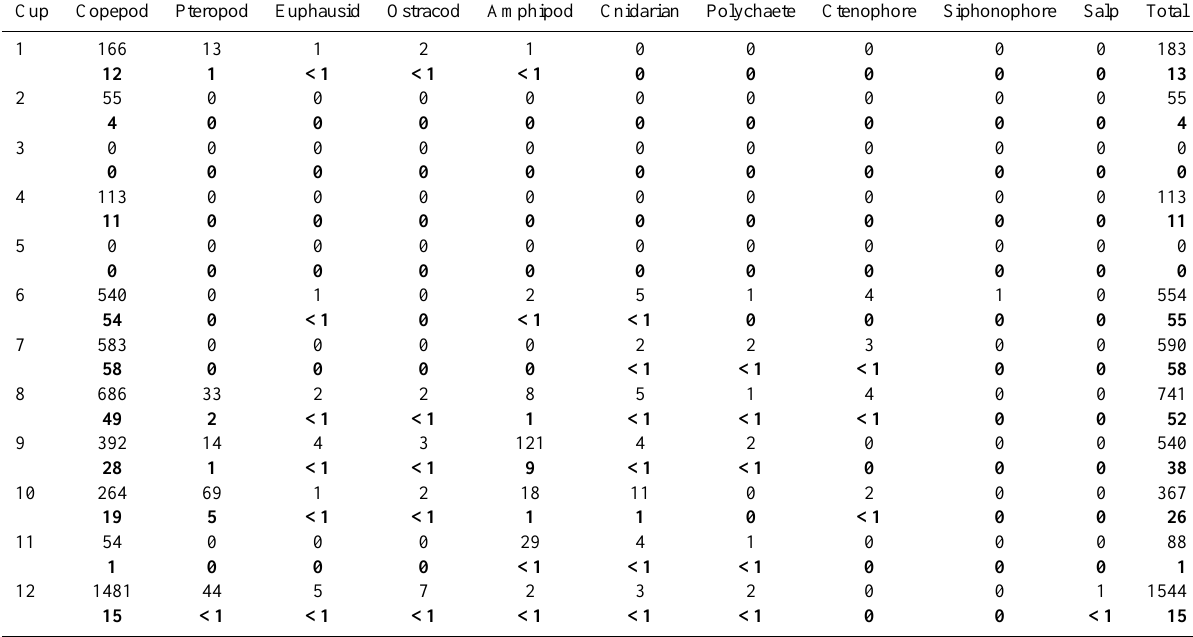
Table 2. Number of swimmer individuals found in each cup and swimmer intrusion rate (number per day, bold numbers) for each taxa and for the total